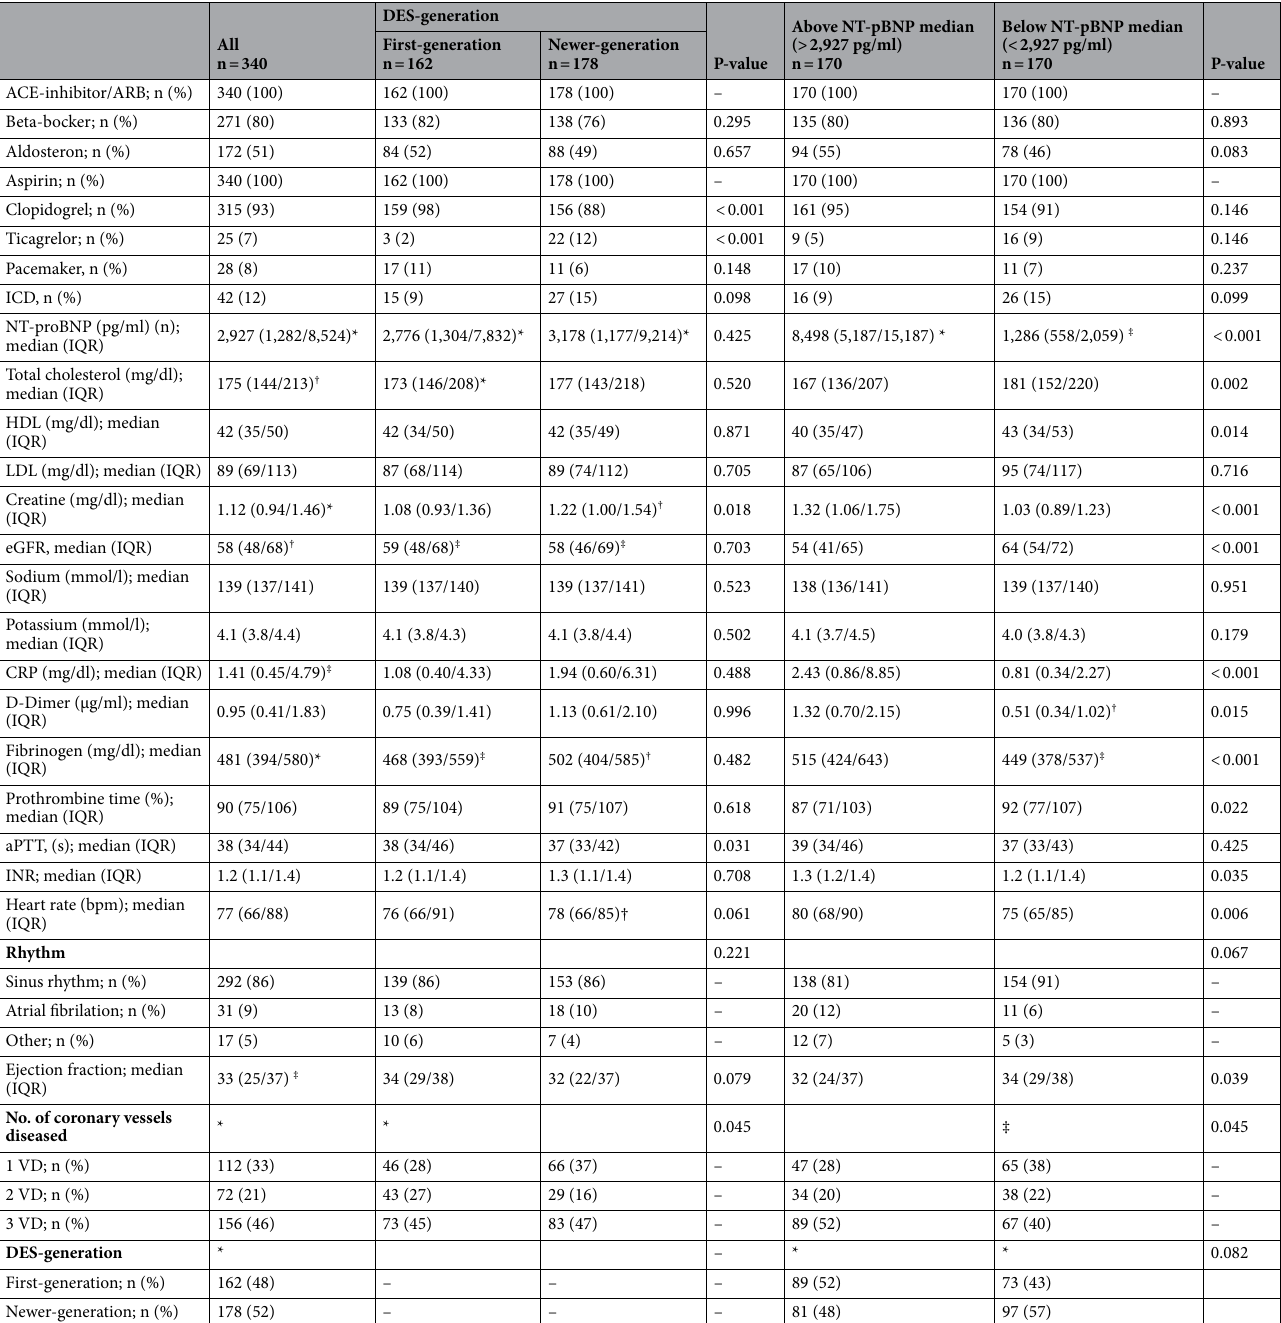
Table 2. Baseline therapy and electrocardiographic, echocardiographic and coronary angiographic results of all patients, subgroups according to DES-generation and subgroups with above and below NT-pBNP